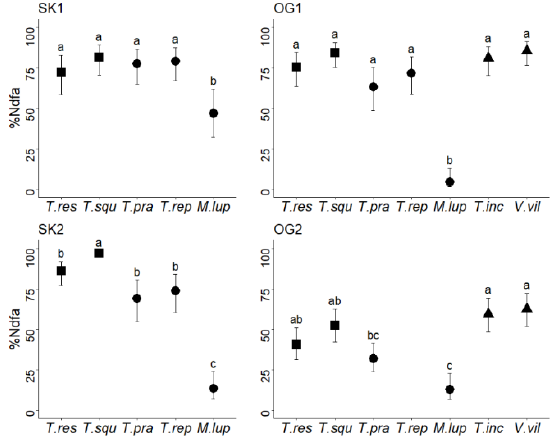
Figure 5. Percent of nitrogen derived from the atmosphere [%Ndfa] before winter in the forage legumes at the four experiments. Abbreviations: SK and OG stand for the two experimental regions, 1 = starting 2017, 2 = starting 2018. Point shapes indicate mixture: frost-sensitive annuals (squares), perennials (circles), and frost-tolerant annuals (triangles). T.res = Trifolium resupinatum , T.squ = T. squarrosum , M.lup = Medicago lupulina , T.pra = T. pratense , T.rep = T. repens , V.vil = Vicia villosa, and T.inc = T. incarnatum . Error bars indicate the 95% confidence interval, and the letters indicate significant differences between treatments within each experiment.